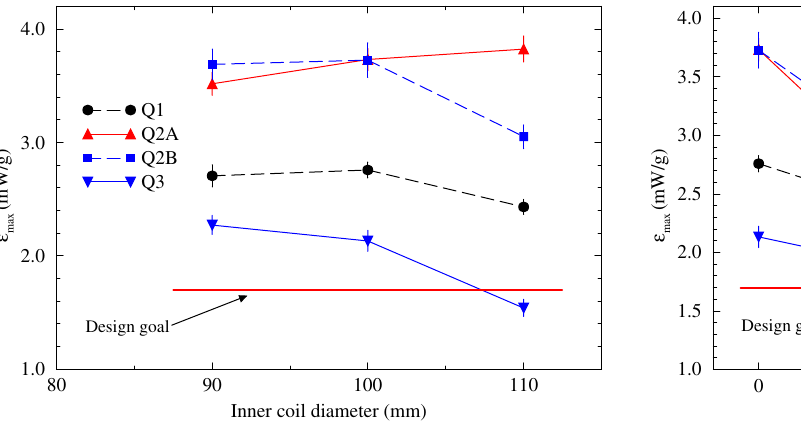
FIG. 6. (Color) Peak power density in the Nb Sn quadrupoles 3 with inner coil diameter of 100 mm vs extra thickness of the stainless steel liner, (cid:1) d . Total thickness of the liner, d , is equal to (cid:6) (cid:1) d , where d d is the baseline liner thickness. 0 0